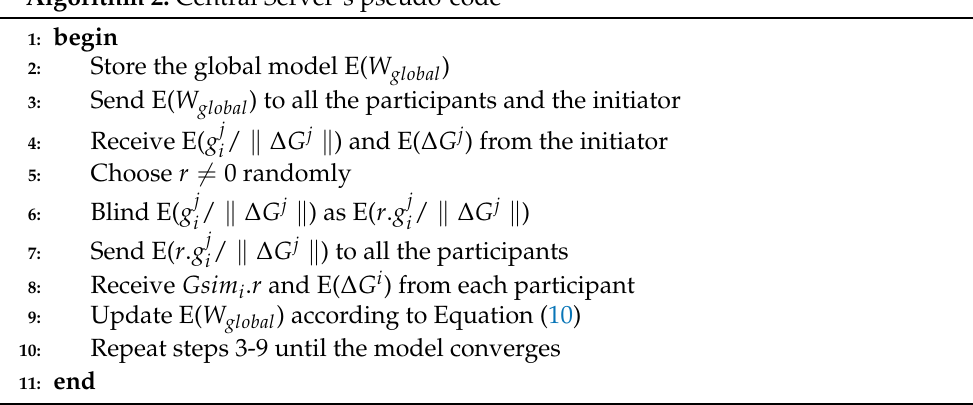
Algorithm 2: Central Server’s